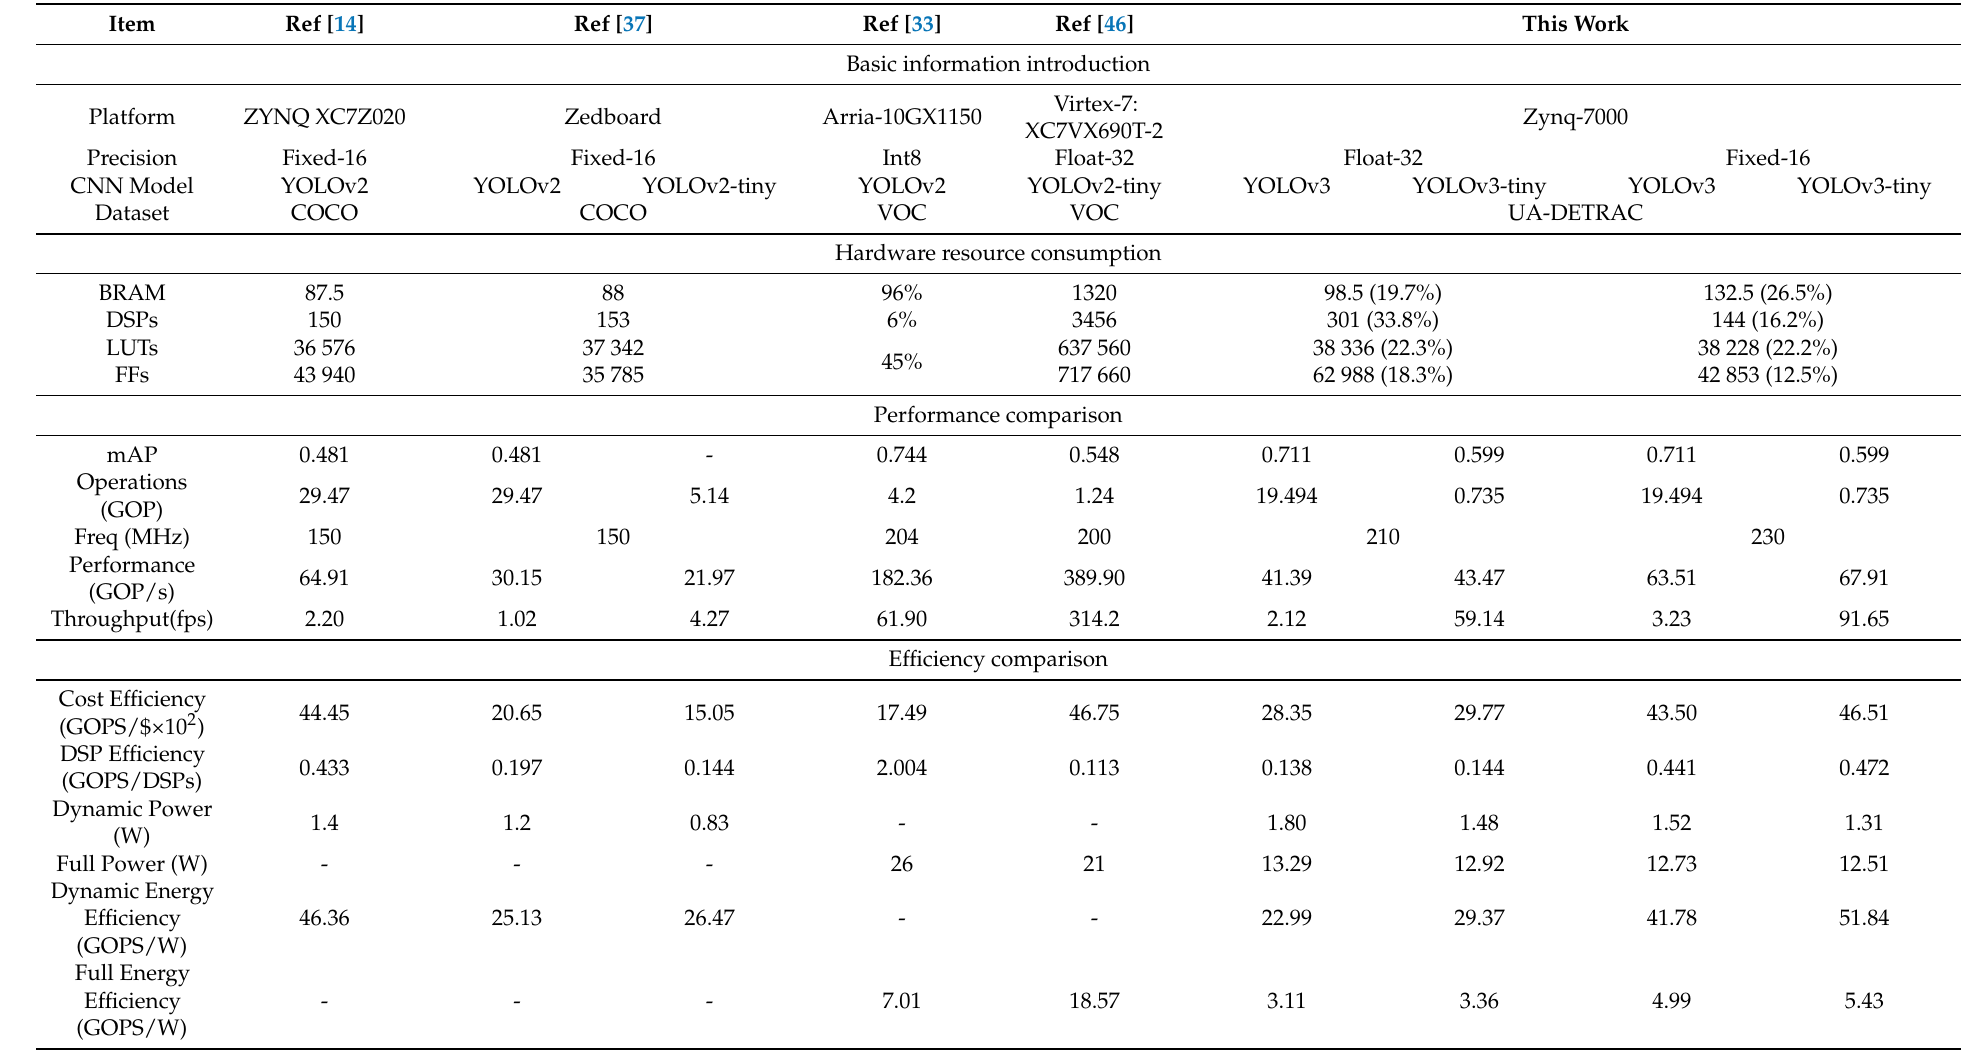
Table 8. Comparison with previous fpga-based